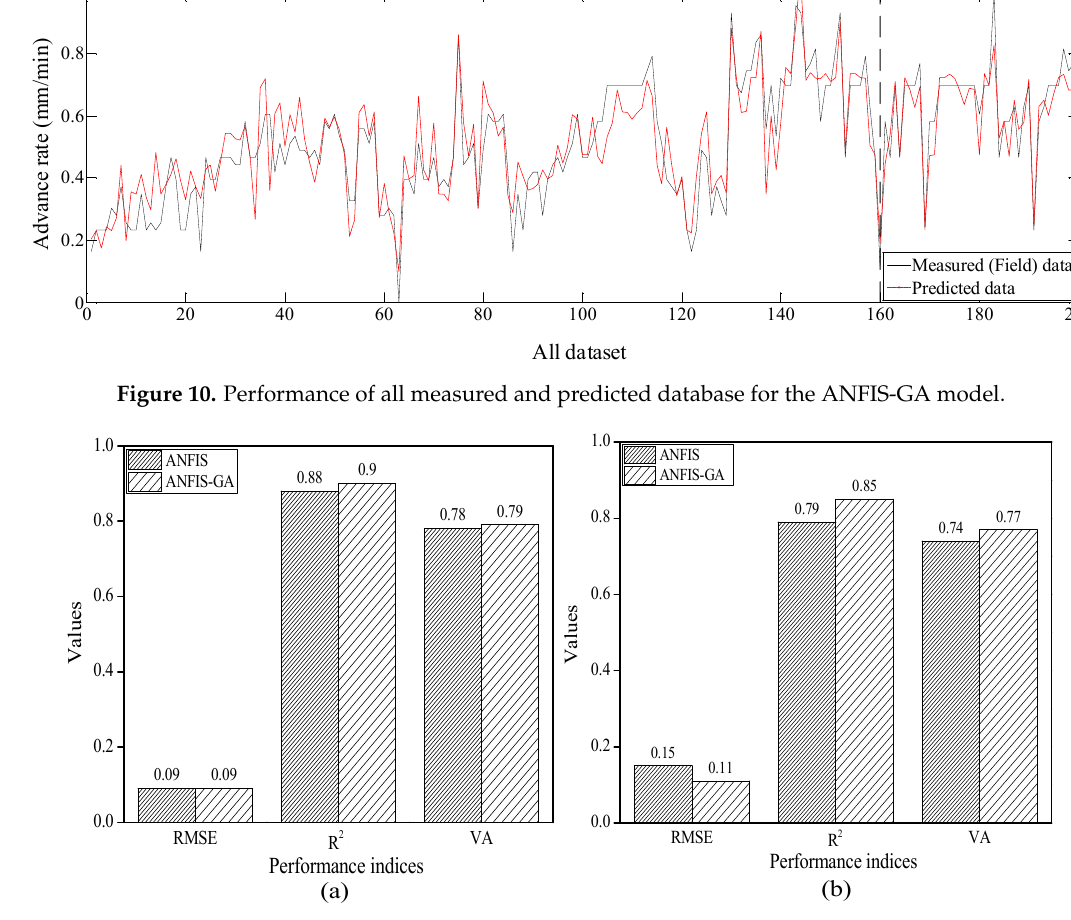
Figure 11. Comparison of performance indices for the ANFIS and the ANFIS-GA: ( a ) training set and ( b ) testing set.